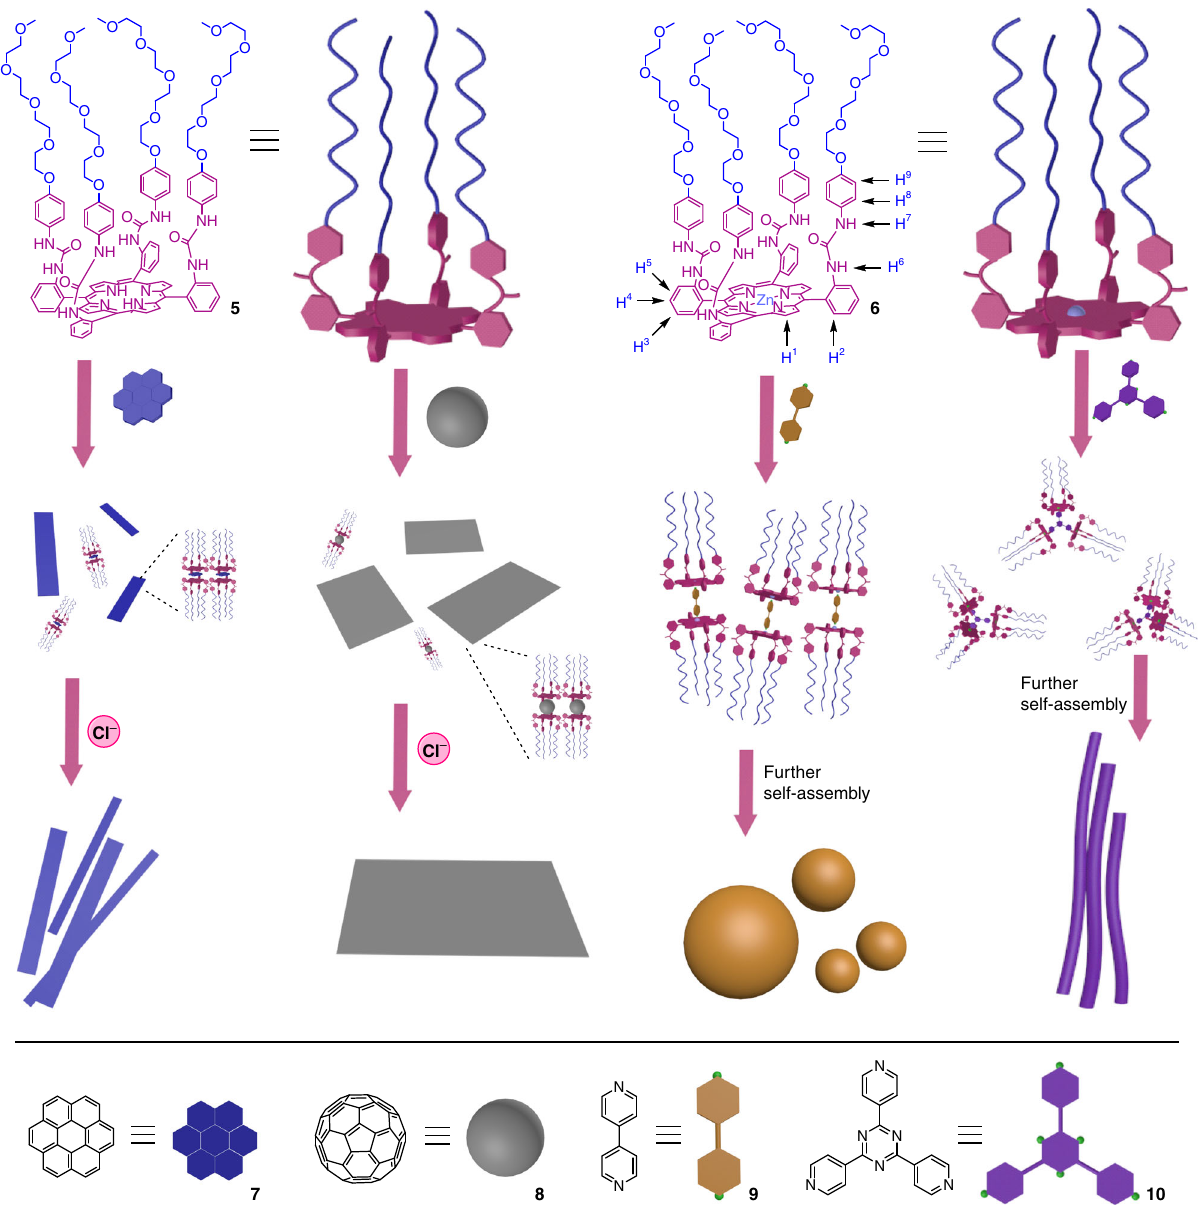
Fig. 2 Hierarchical self-assembly of the amphiphilic porphyrin 5 and Zn-porphyrin 6 controlled by the addition of different